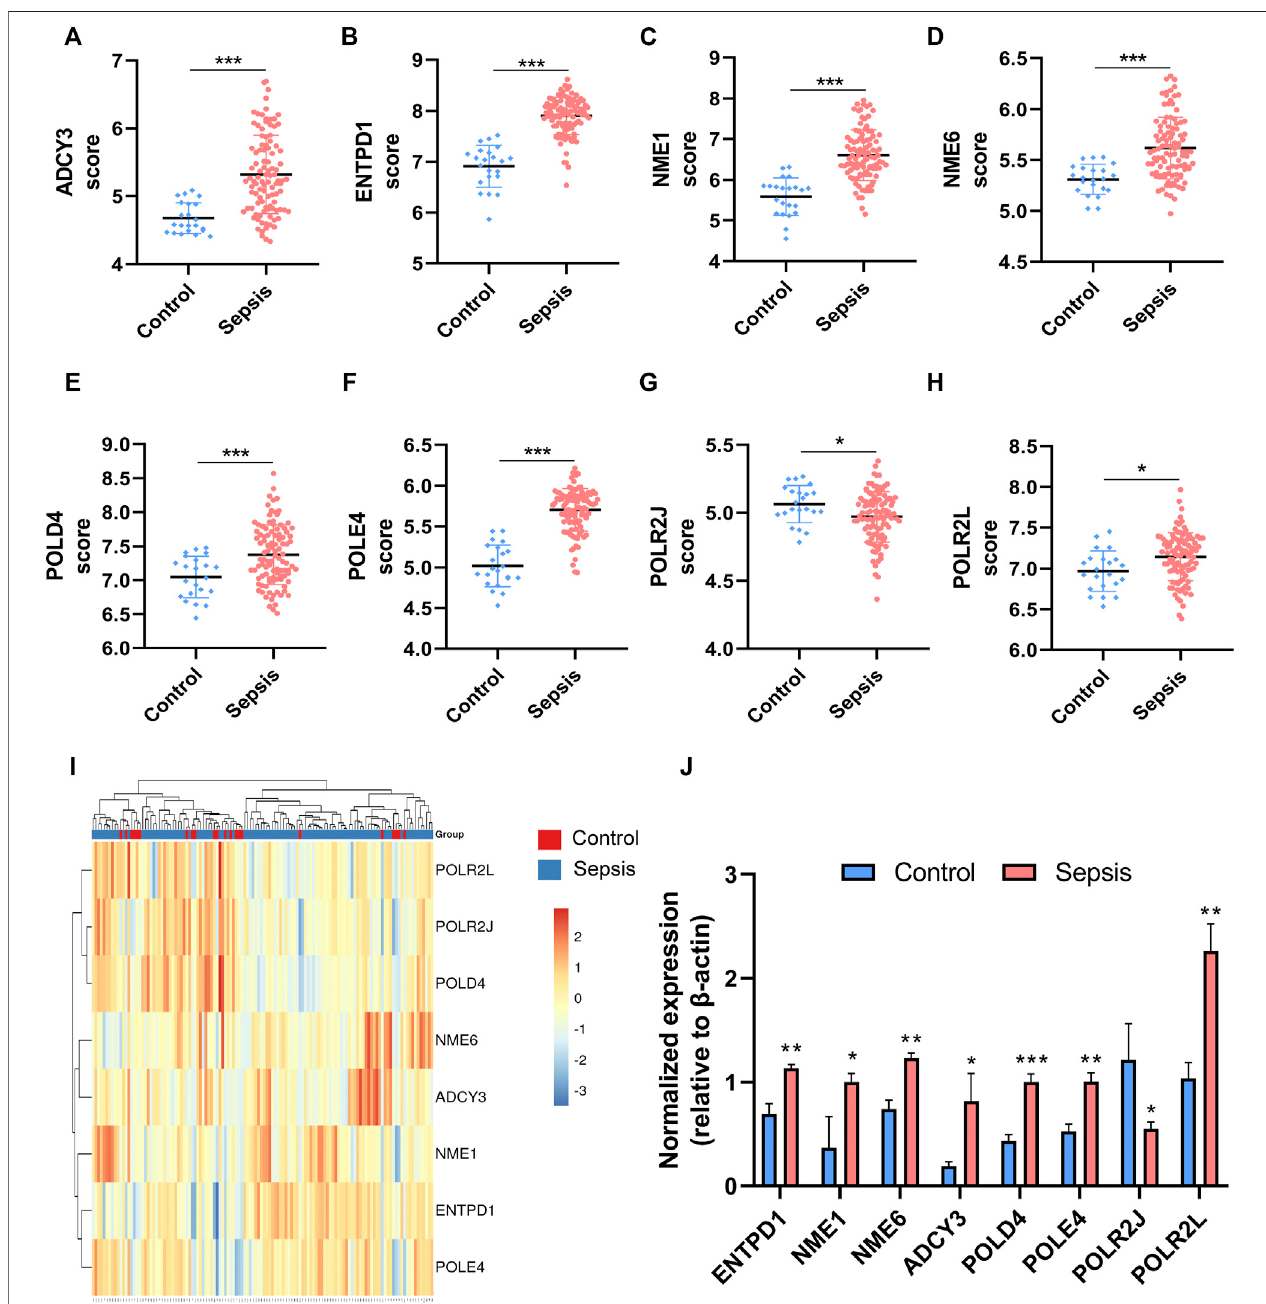
FIGURE 5 | The expressions of the hub genes were different between sepsis patients and healthy controls in the training dataset GSE95233. (A – H) Validation of expression of metabolic-related hub genes in patients with sepsis and normal controls in GSE95233. (I) Hierarchical clustering analysis demonstrates identi fi ed metabolic-relatedgeneexpressionpatternsofhearttissuesbetweensepticratandnormalgroupsinthetrainingcohort. (J) Relativeexpressionofidenti fi edhubgenesin myocardialtissueswascompared betweensepticratsand controlratsusing quantitative real-time PCR.Differencesbetweentwogroupswereanalyzed using